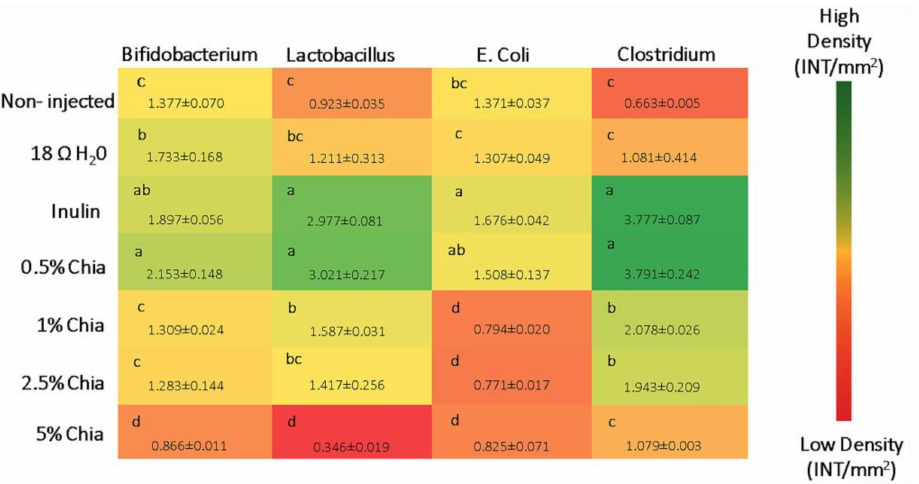
Figure 3. Genera- and species-level bacterial populations (AU) from cecal contents measured on the day of hatch. Values are the means ± SEM, n = 10. a–d Per bacterial category, treatment groups not indicated by the same letter are significantly di ff